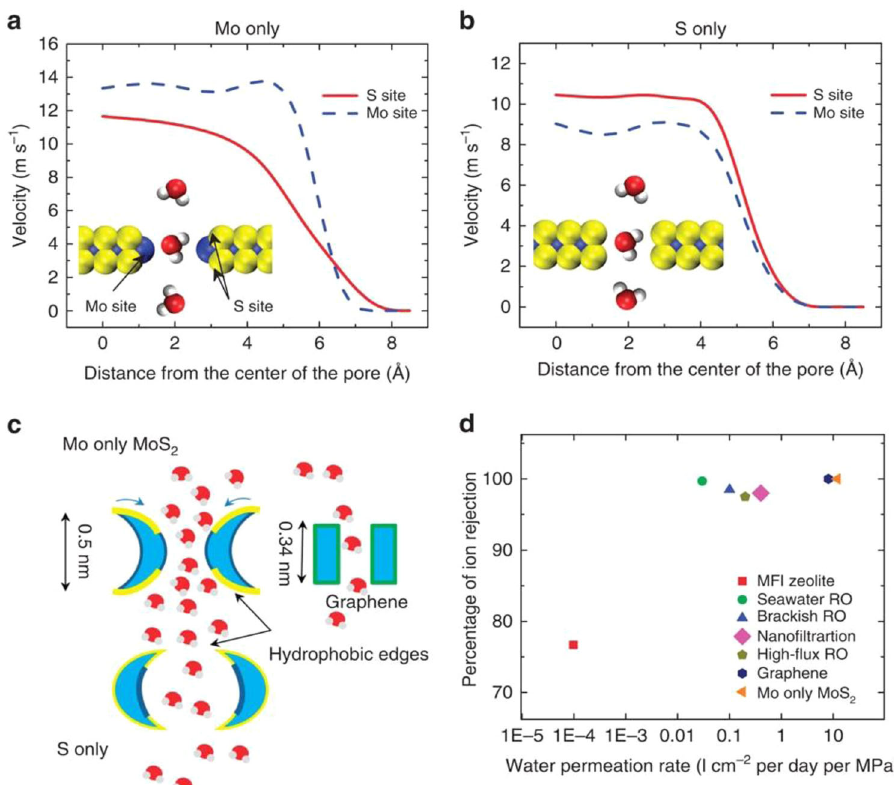
Fig. 8 Effects of pore type on salt rejection and water permeation. a The velocity pro fi le of the water molecules at the Mo only edges of the nanopores ( b ) Water molecules velocity pro fi le at the edges of the nanopores of the S only atoms. c The schematic representation of the different pore architectures for the Mo only and S only compared to graphene nanopore. d The performance comparison of the various membranes ion rejection and the water permeation rate 32 . Reproduced with permission from Heiranian et al. Nat. Commun. 6, 8616,